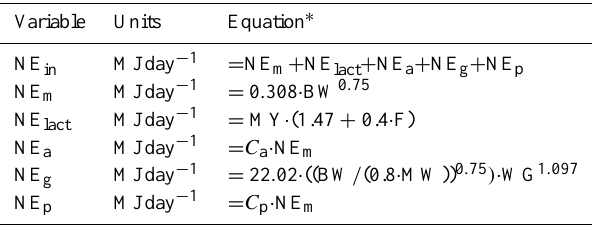
Table 1. Equations used to estimate net energy (NE) requirements in dairy